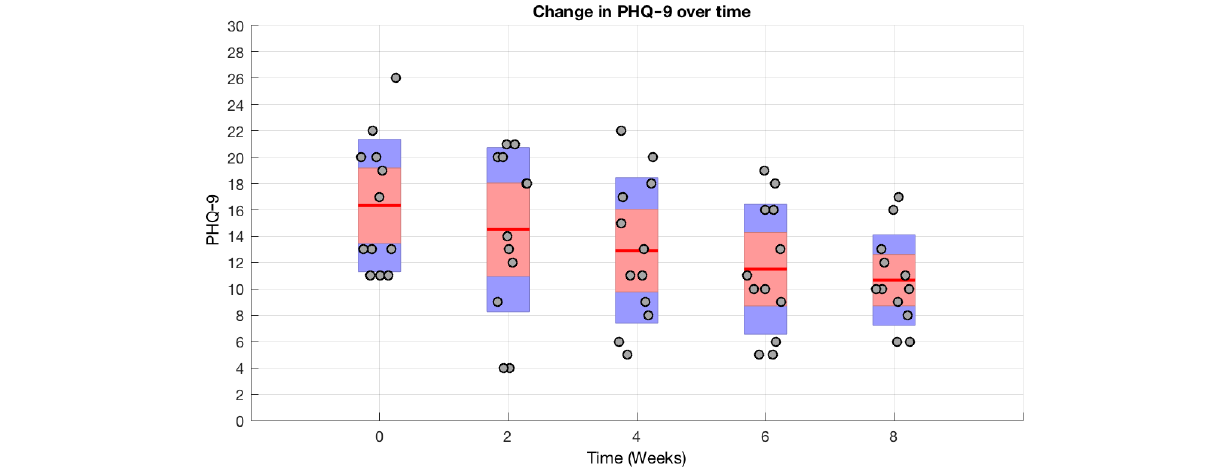
Figure 7. Plot of PHQ-9 progression of clinically depressed individuals over time. Note: Gray dots represent individual PHQ9 values, red lines show distribution mean for each time point, the red area shows the 95% confidence interval for the mean, the blue surface shows 1 standard deviation.